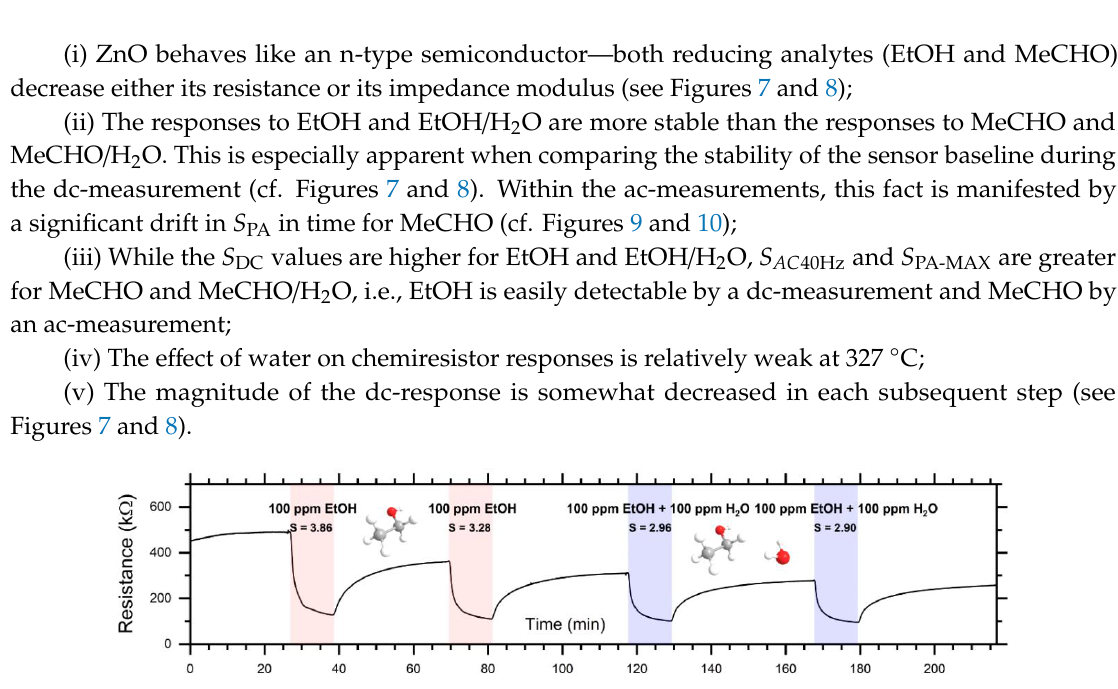
Figure 7. Responses of the ZnO-nanorod-based chemiresistor to EtOH and EtOH/H 2 O vapours. The sequence of atmospheres was as follows: reference air → 100 ppm EtOH → reference air → 100 ppm EtOH → reference air → 100 ppm EtOH + 100 ppm H 2 O → reference air → 100 ppm EtOH + 100 ppm H 2 O → reference air.